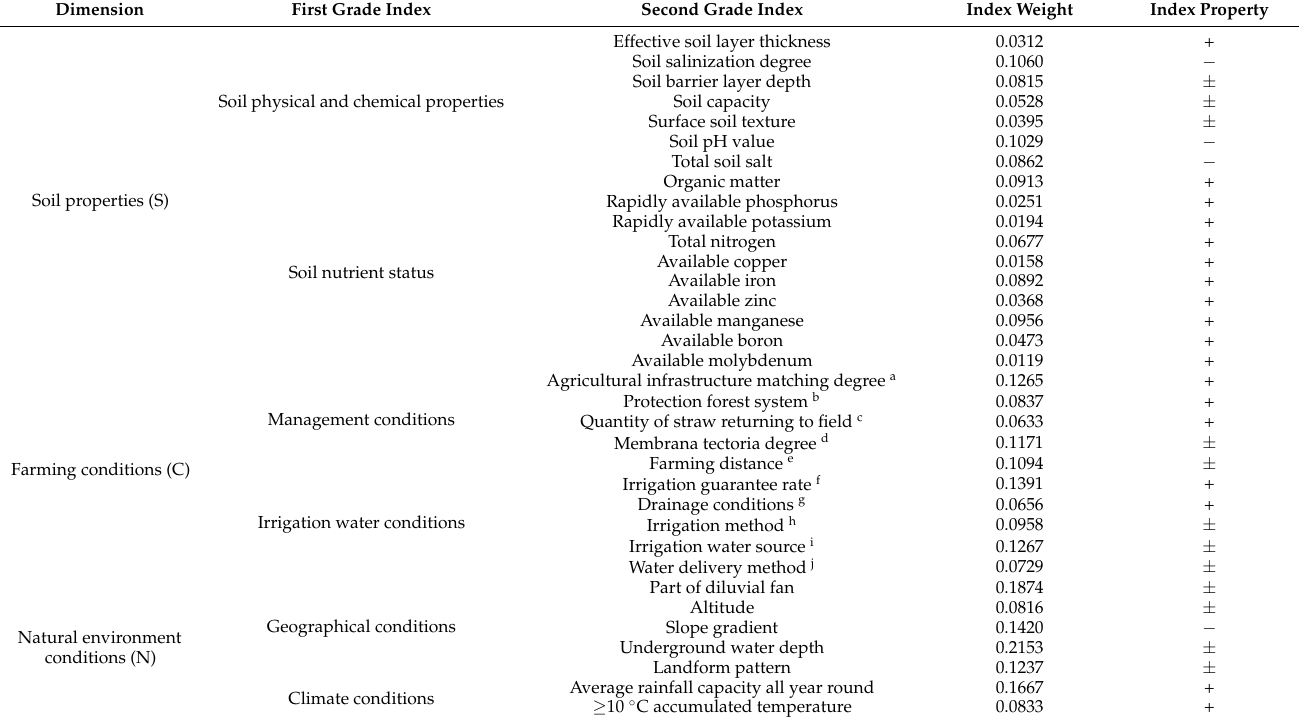
Table S1 in the Supplementary Materials. Table 1. Cultivated land quality evaluation index system and weight